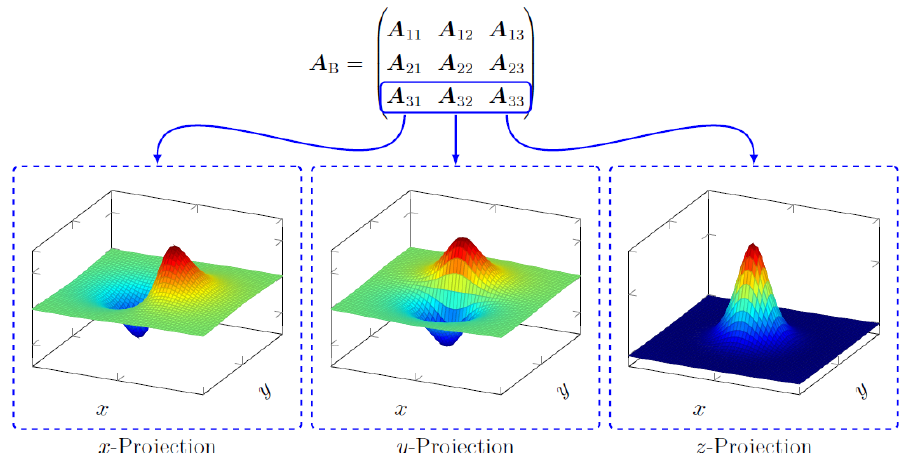
Figure 2. The individual model matrices corresponding to the different combinations of magnetic moment direction and sensitive axis direction refer to different PSFs for the imaging system. In this section, we take the projections for the magnetic moment in the z direction, which is indicated by the model matrices enclosed by the blue borders. The dashed boxes show the corresponding PSFs for the model